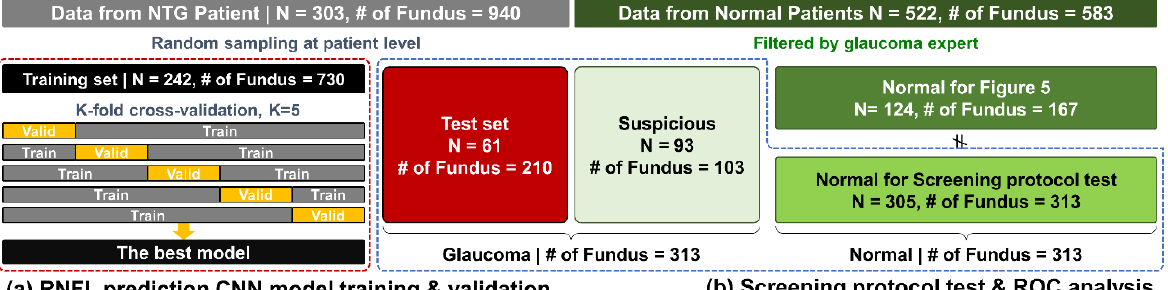
Table 2. A summary of performance metrics. The mean-absolute-error (MAE), the R-squared, and the Pearson’s correlation coefficient between prediction of RNFL from trained models and true OCT-measurements.